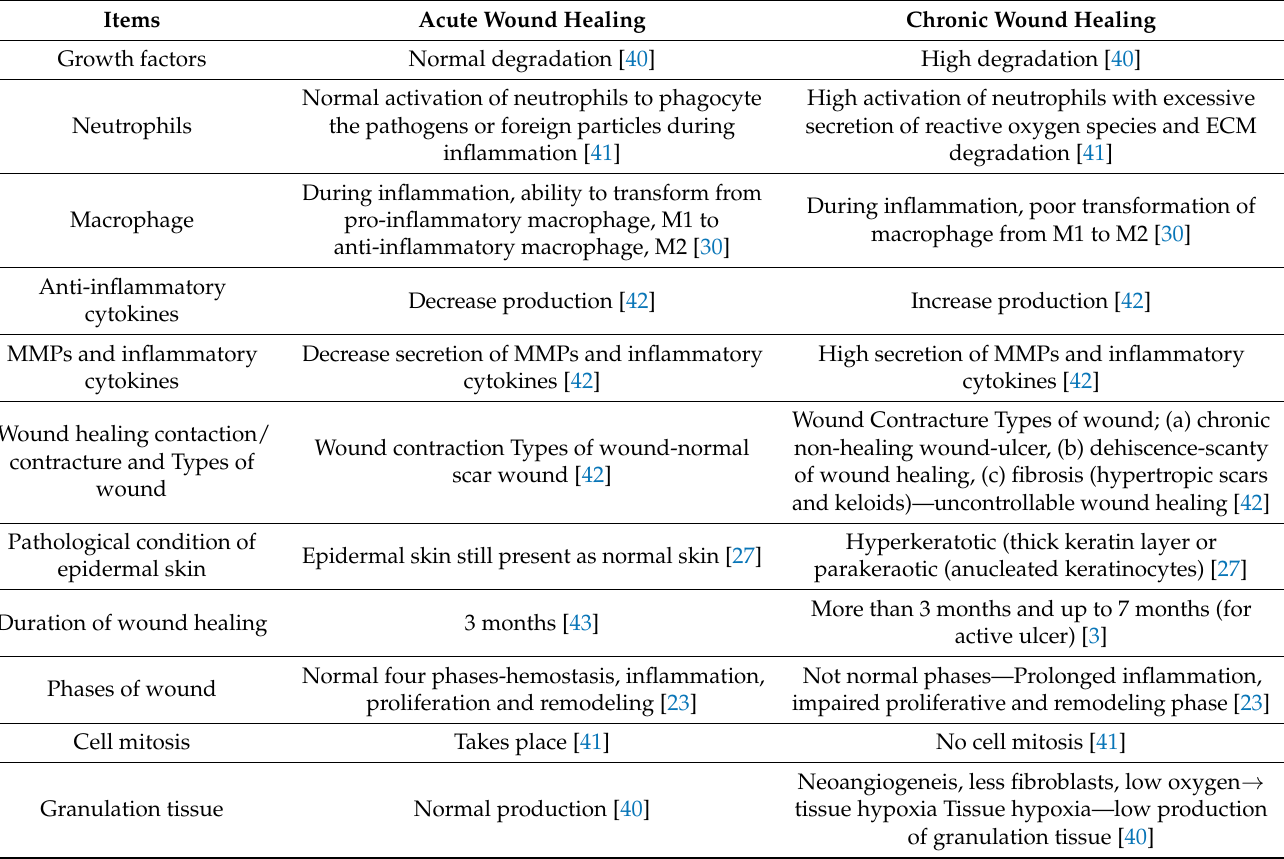
Table 1. Differences between acute and chronic wound